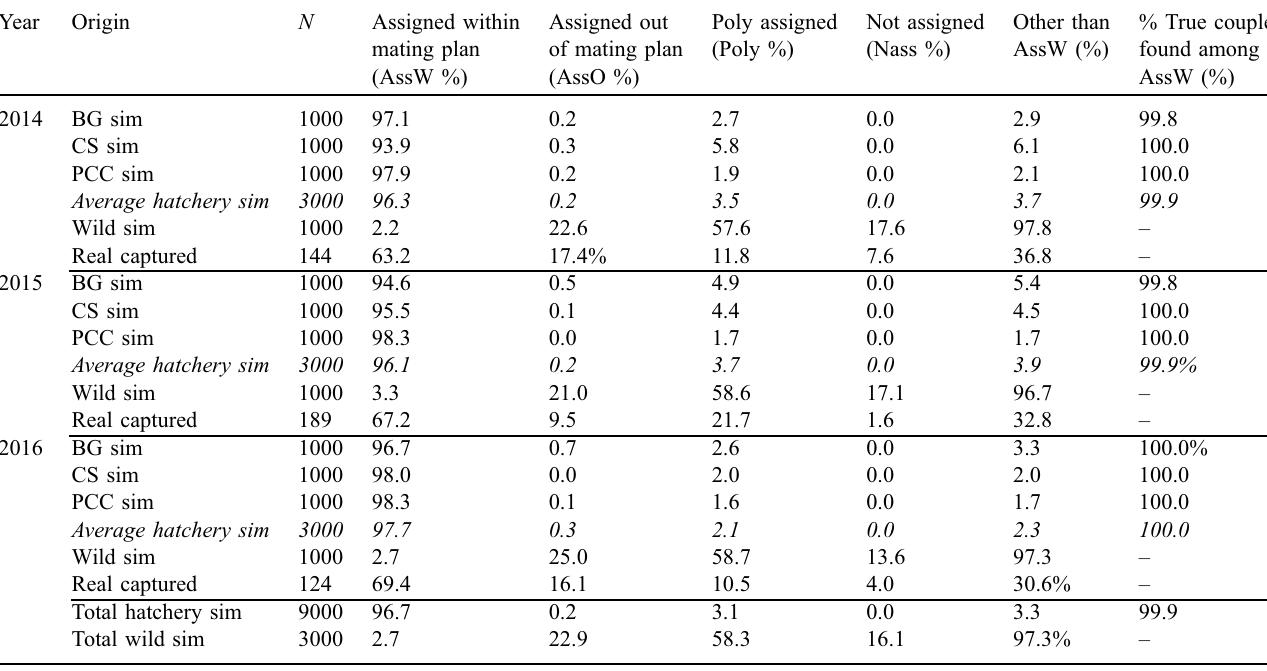
Table 4. Parentage assignment of Atlantic salmon offspring with simulated genotypes at 9 microsatellite markers, for three salmon run years (2014 – 2016) in the Garonne-Dordogne Basin.